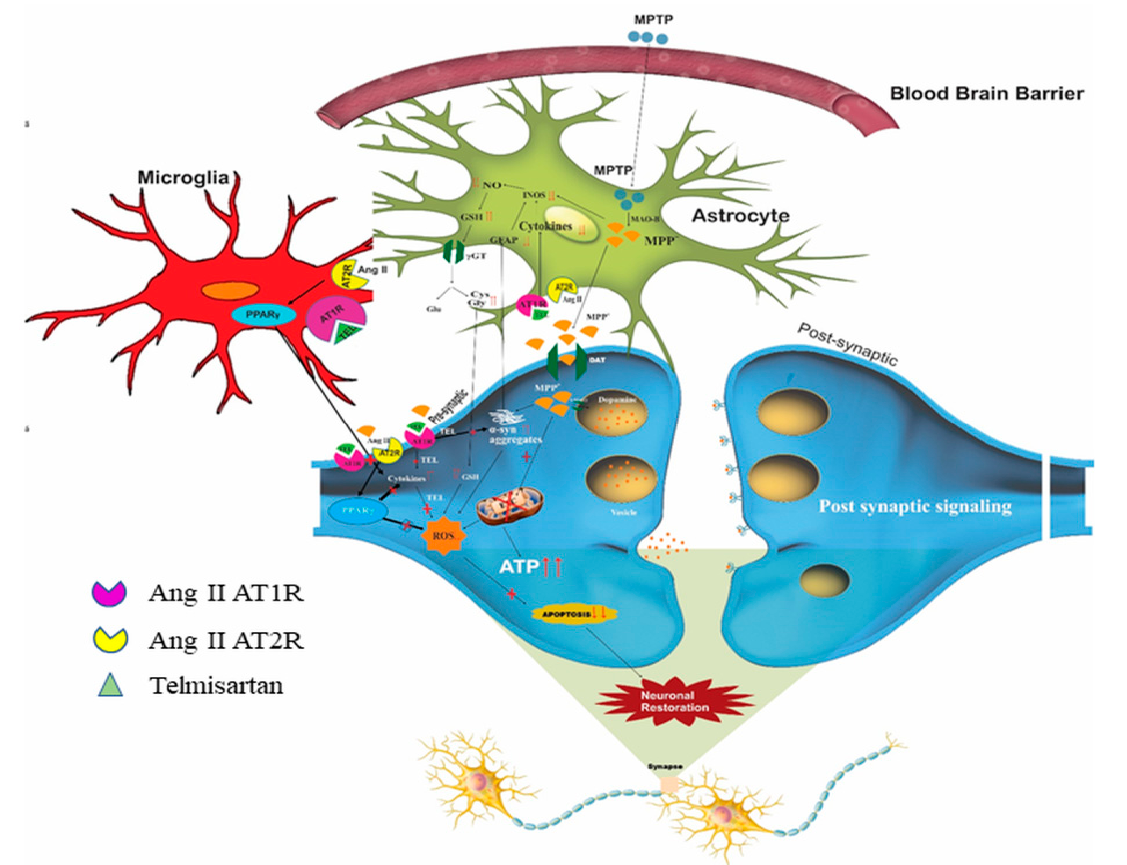
Figure 3. An overview on the distribution of RAS components in neurons, astrocytes and microglia, and the possible mechanism of AT1 receptor antagonist in MPTP induced PD. (Reused as per the copyright guidelines from Springer Nature; Neurotoxicity Research, “Telmisartan Ameliorates Astroglial and Dopaminergic Functions in a Mouse Model of Chronic Parkinsonism”, Sathiya Sekar et al. 2018.(132)). When administered systemically, neurotoxins, such as MPTP cross the BBB and reach the glial cells. MPTP is converted to MPDP + by glial MAO-B, which is subsequently converted to MPP + . This toxic MPP + released from the astrocytes enters the DA neurons via the dopamine transporters. Accumulation of MPP + causes neurotoxicity by inhibiting the mitochondrial ETC (complex I), thereby leading to the depletion of ATP, increase in oxidative stress, and, ultimately, neuronal death. The existence of all RAS components, including the angiotensin receptors have been identified in the brain. ATR1/2 and angiotensinogen are expressed in the cell membrane and in astrocytes. An increase in the circulating brain RAS plays a major role in the progression of PD pathophysiology. Therapeutic use of angiotensin receptor blockers provides neuroprotection in various neurodegenerative diseases. TEL, an AT1R blocker, protects the dopaminergic neurons by upregulating TH, DAT, and vesicular VMAT2 expressions, as well as by decreasing oxidative stress and inflammatory cytokine release.